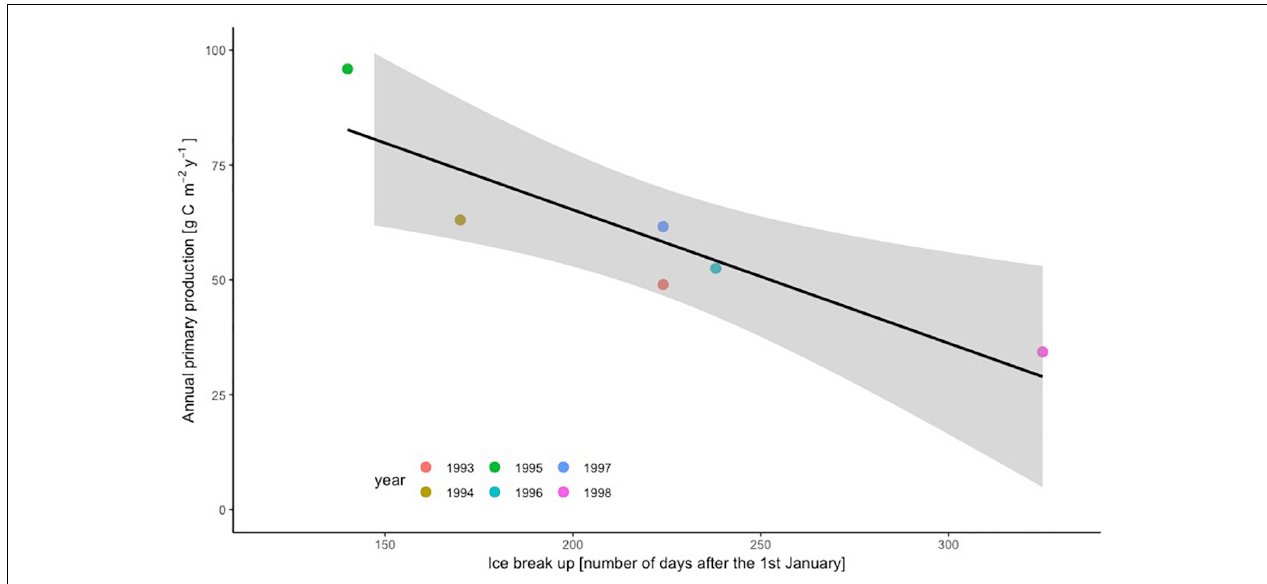
FIGURE 10 | Relationship between annual primary production and ice break-up timing for the 7 years simulated at the central Barents Sea station. Values ( p = 0.0159, R 2 adjusted =